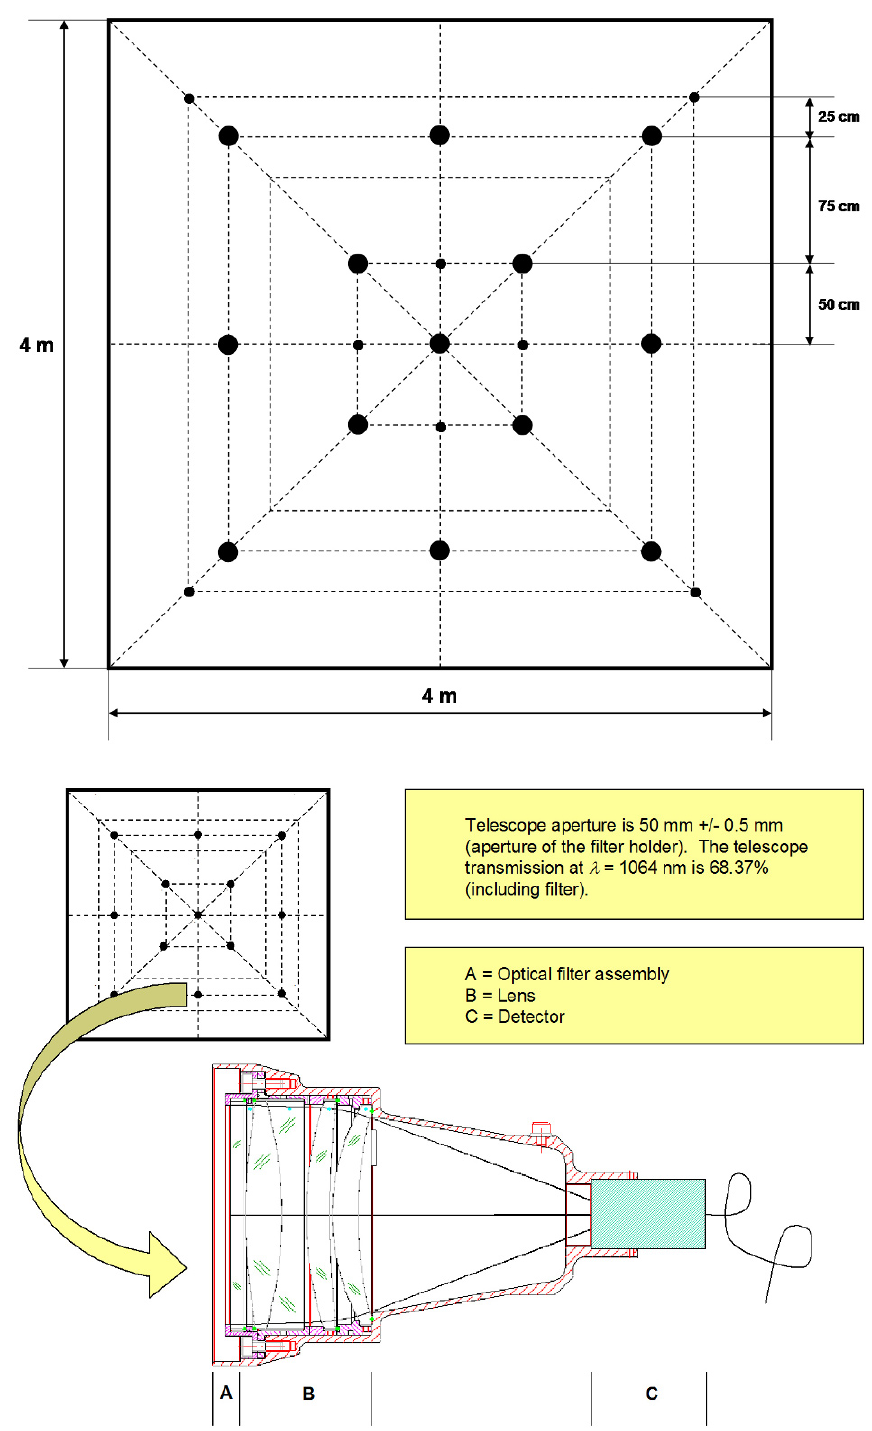
Figure 5. Target layout for LMT-B non-calibrated